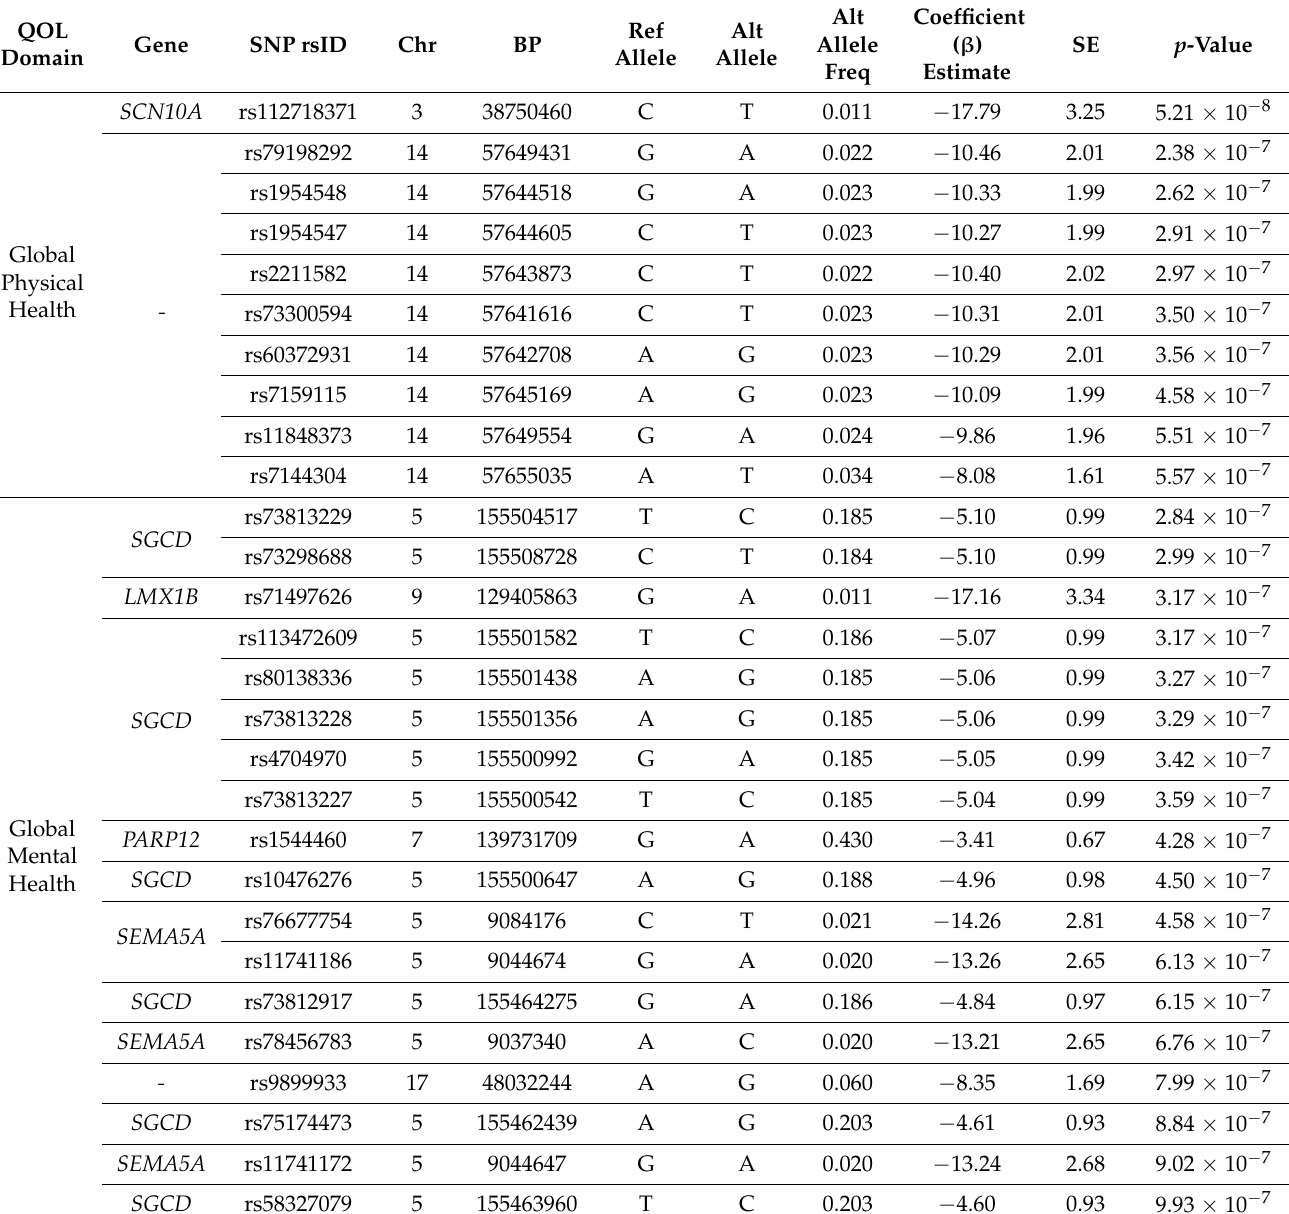
Table 3. SNPs with p -values < 10 − 6 for associations with PROMIS-10 global physical and mental health.